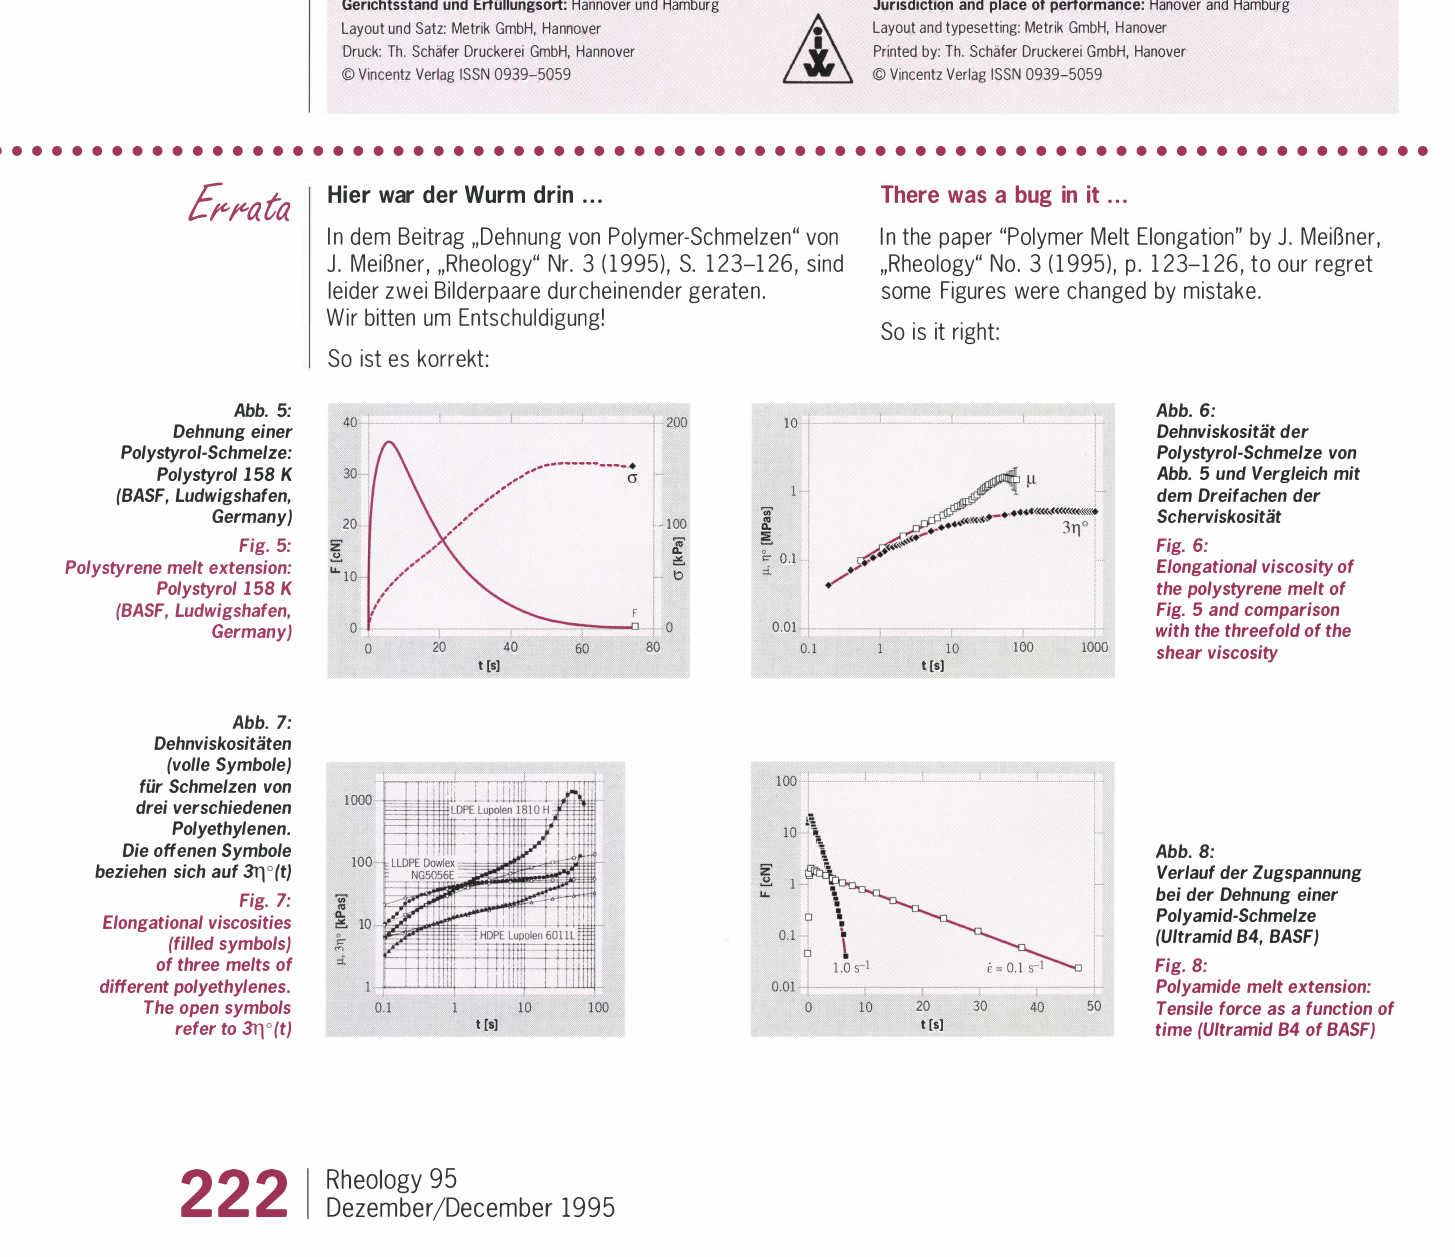
Fig. 5: Polystyrene melt extension: